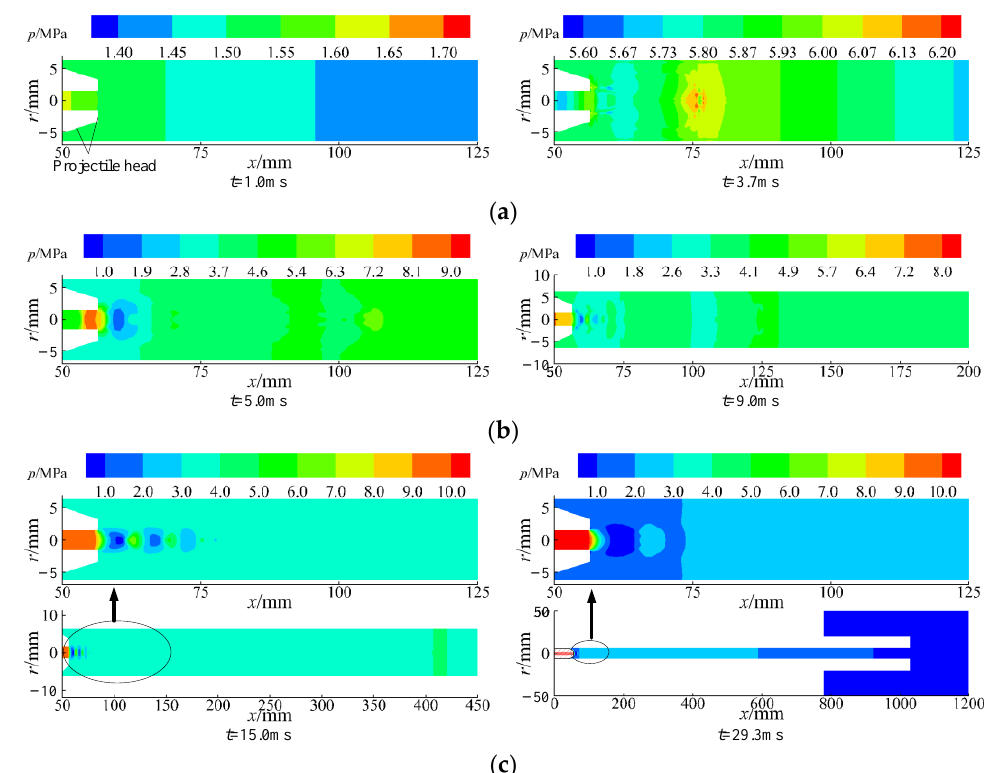
Figure 9. Pressure distribution (projectile A). ( a ) The first stage; ( b ) the second stage; ( c ) the third stage.